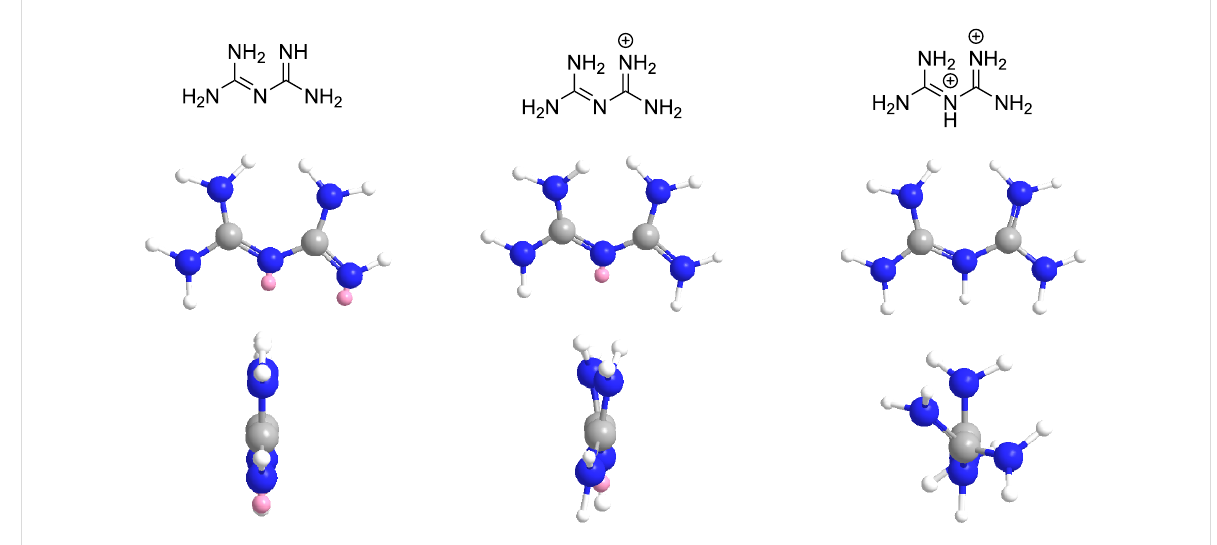
Figure 2: Illustrations of neutral, monoprotonated, and diprotonated structures biguanide.